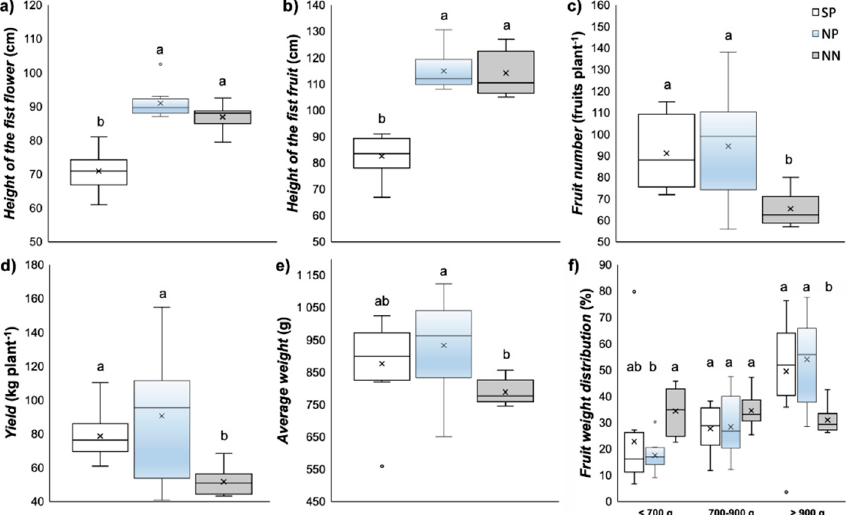
the same letter are not significantly different according to the LSD test, at a significance level of